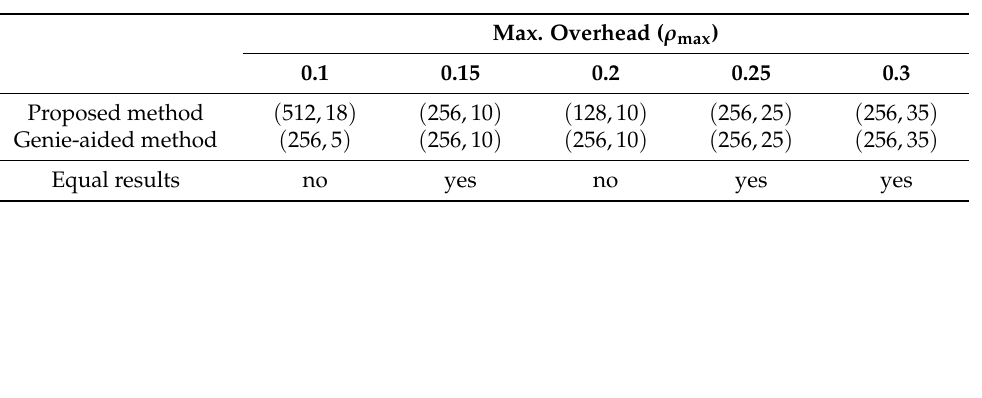
Table 8. Parameters chosen by each method for KAU1